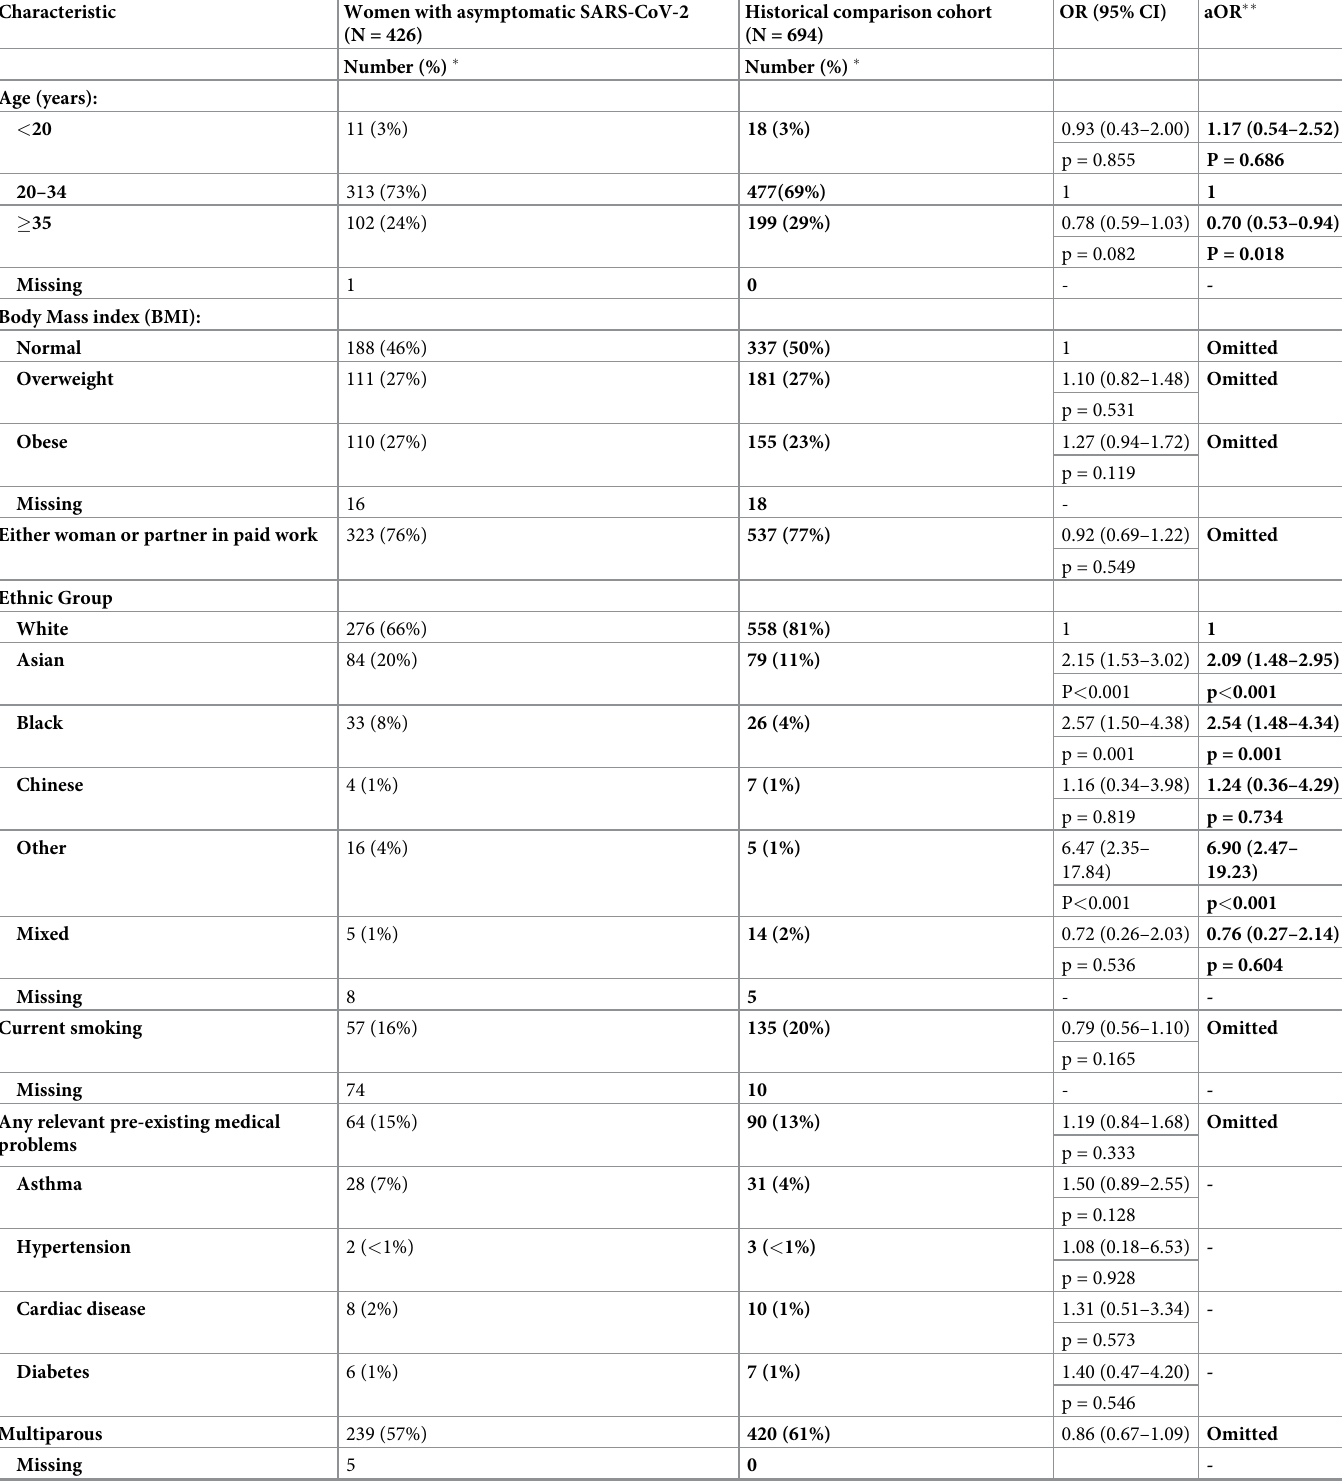
Table 2. Characteristics of pregnant women with asymptomatic confirmed SARS-CoV-2 infection admitted to hospital in the UK compared to a historical cohort without SARS-CoV-2